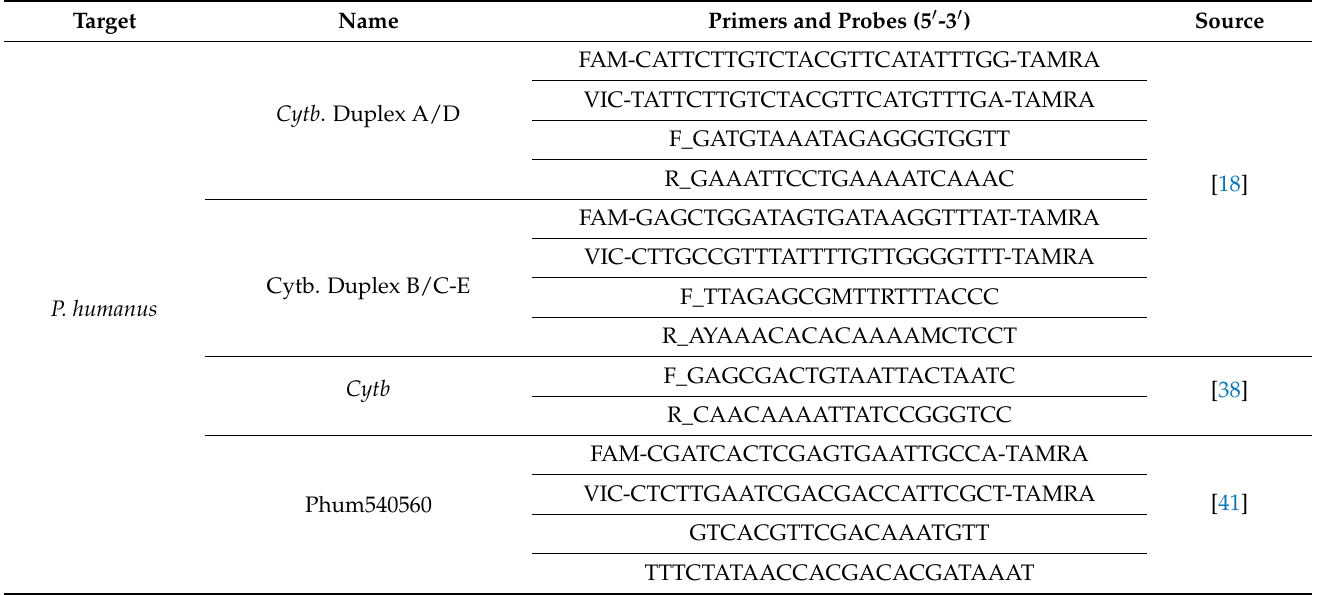
Table 1. Real time PCR and conventional PCR primers and probes used in this